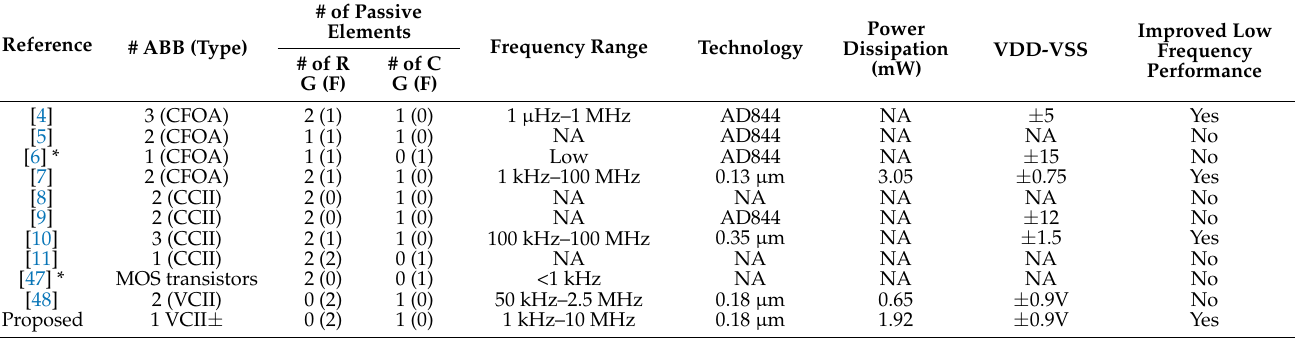
Table 2. A comparison among the proposed circuit and some other previously reported similar